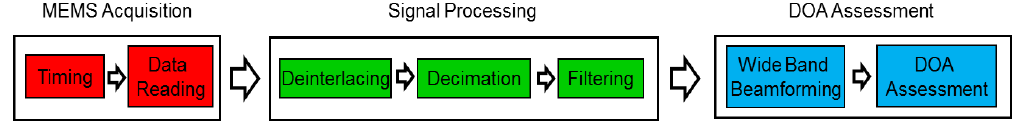
Figure 4. Processing algorithms.